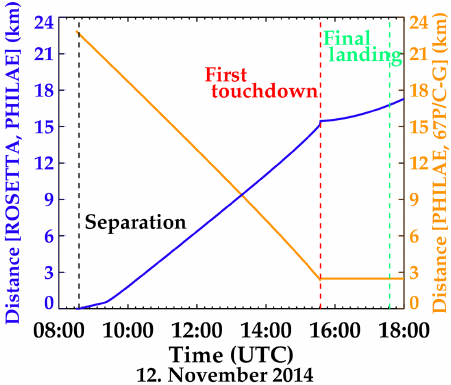
Figure 2. The energy density of the observed waves in dependence of the radial distance between ROSETTA and 67P/C-G for 1 year of observations. Time segments are colour-coded.